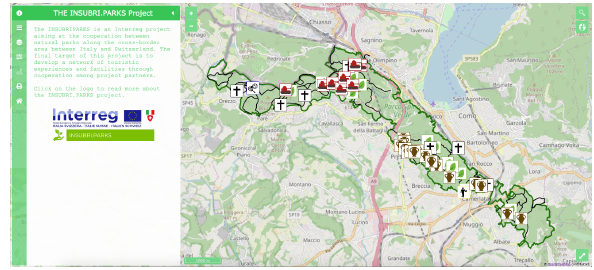
Figure 3. Prototype of the INSUBRI.PARKS WebGIS